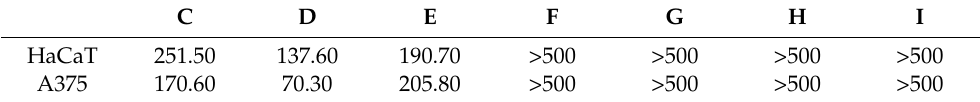
Table 6. Cytotoxicity of C-I fractions of closed flower extract (R3) of R. platyacantha (IC 50 , µ g/mL).